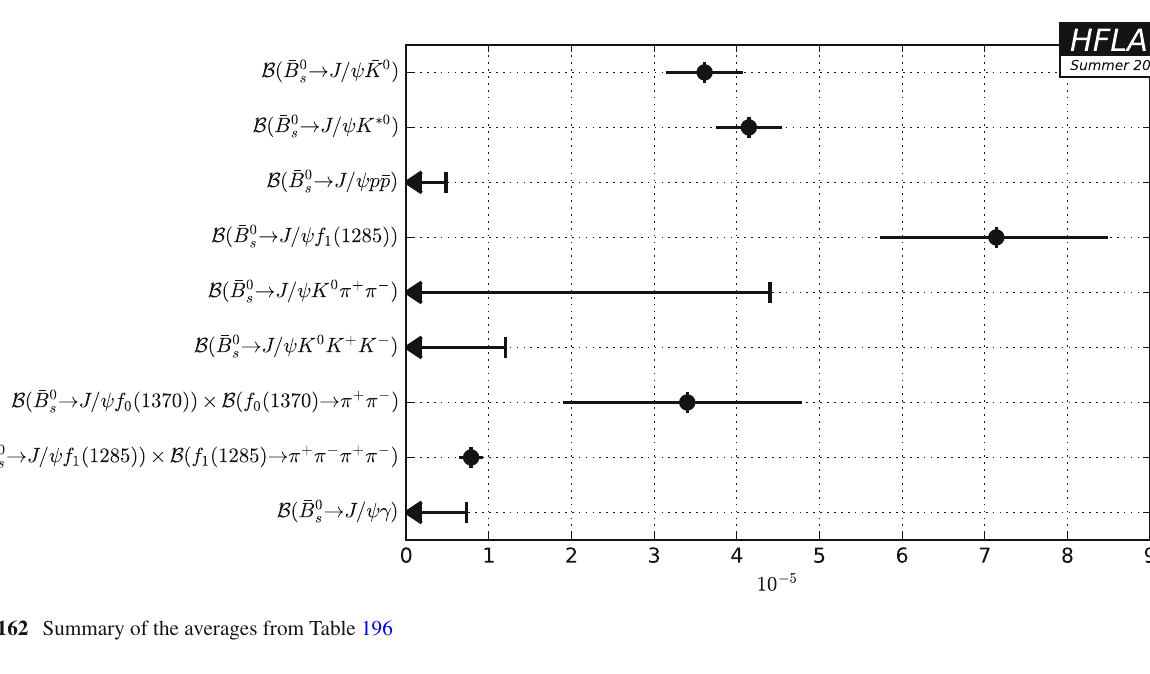
Fig. 162 Summary of the averages from Table